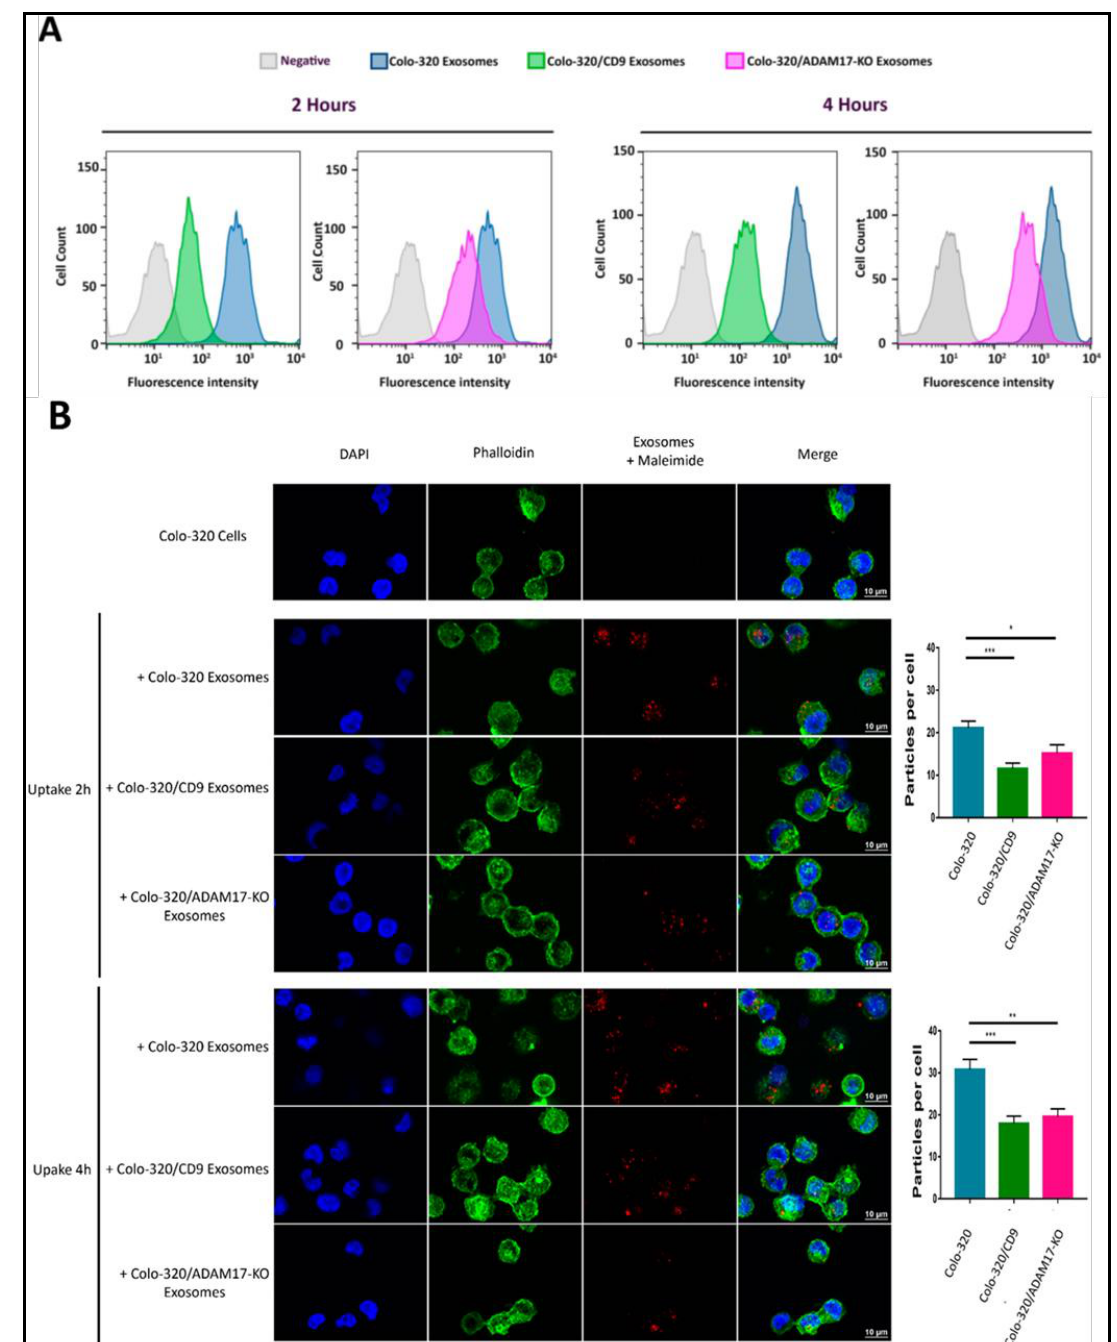
Figure 5. Expression of exosomal CD9 and knocking-out ADAM17 expression in exosomes reduced the uptake of exosomes by Colo-320 recipient cells. ( A ) Flow cytometry quantitation of the uptake by Colo-320 recipient cells of fluorescently labelled exosomes produced by Colo-320, Colo-320/CD9 and Colo-320/ADAM17-KO cells, after 2 and 4 h or cell − exosome co-incubation. ( B ) Confocal microscopy images showing the uptake by Colo-320 recipient cells of the different exosomes as in ( A ). The bar graphs show the quantification of exosomal uptake by counting the particles internalized by at least 80 cells for each condition in three separate experiments. Statistical analysis performed was one-way ANOVA. * p < 0.05, ** p < 0.01 *** p < 0.001.